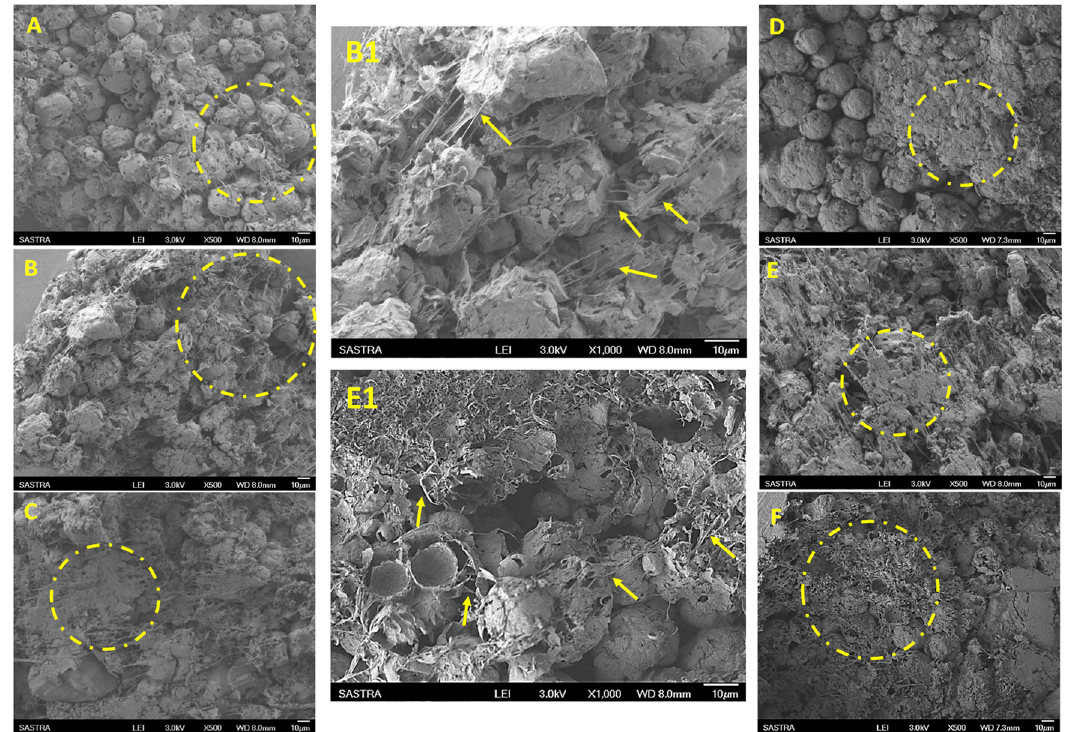
Fig. 4 Scanning electron micrographs of cells cultured on SS after ( A ) 1 day. ( B ) 14 days. ( B1 ) Higher magni fi cation at 14 days ( C ) 21 days and on P-SS scaffolds after ( D ) 1 day. ( E ) 14 days; ( E1 ) Higher